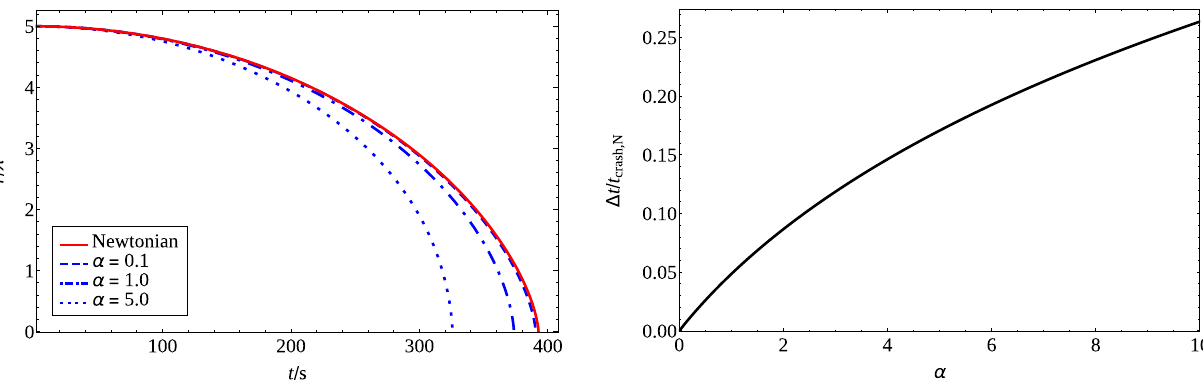
Fig. 1 Left: normalized distance a = r /λ between the Satellite, S, and the source of the gravitational field, P, as a function of time, in the case of Newtonian (red solid line) and Beyond-Newtonian motion (bluenon-solidlines).Theinitialconditionsare a 0 = 5and ˙ a 0 = 0,with k = G N m P /λ 3 = 10 − 3 s − 2 and λ = 10 μ m for different α : α = 0 . 1